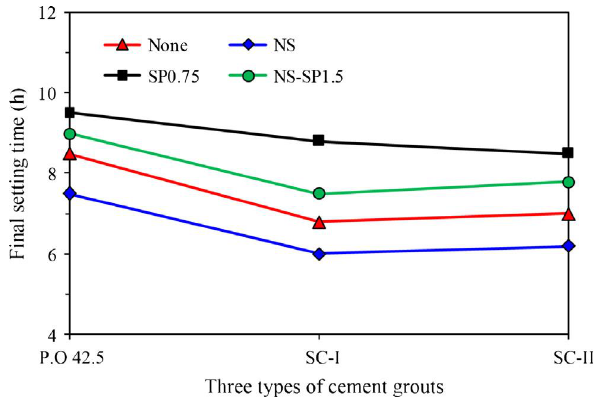
Figure 1: Final setting time of different cement grouts [54]